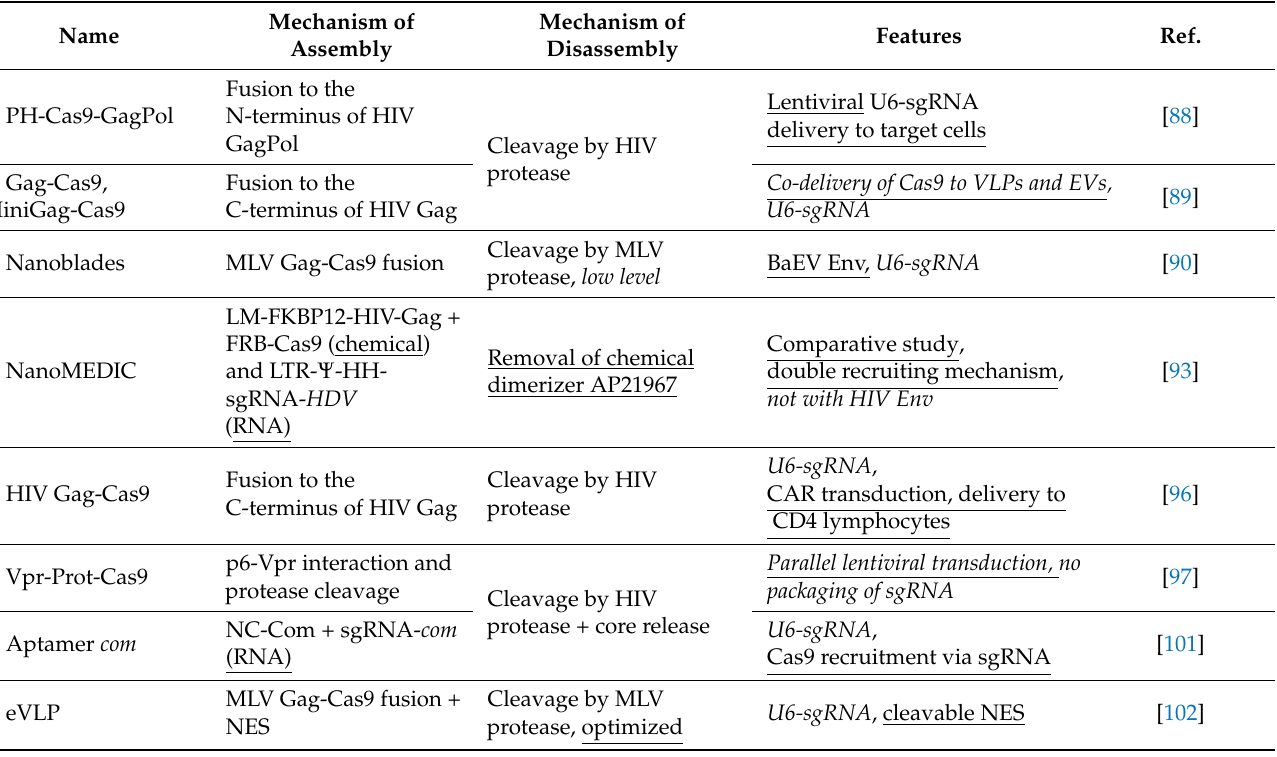
Table 2. Current systems for delivery of Cas9 RNP using VLPs. The pros and cons of each system are indicated by underlining or italicizing,